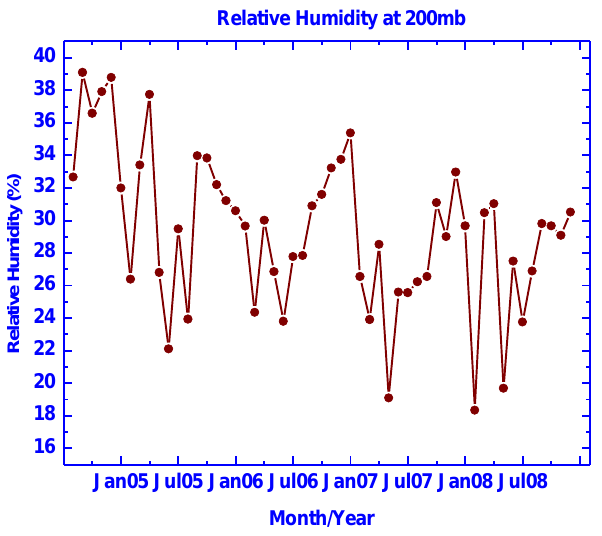
Fig. 2. Variation of relative humidity obtained from NCEP/NCAR reanalysis data at 200mb during August 2004–June